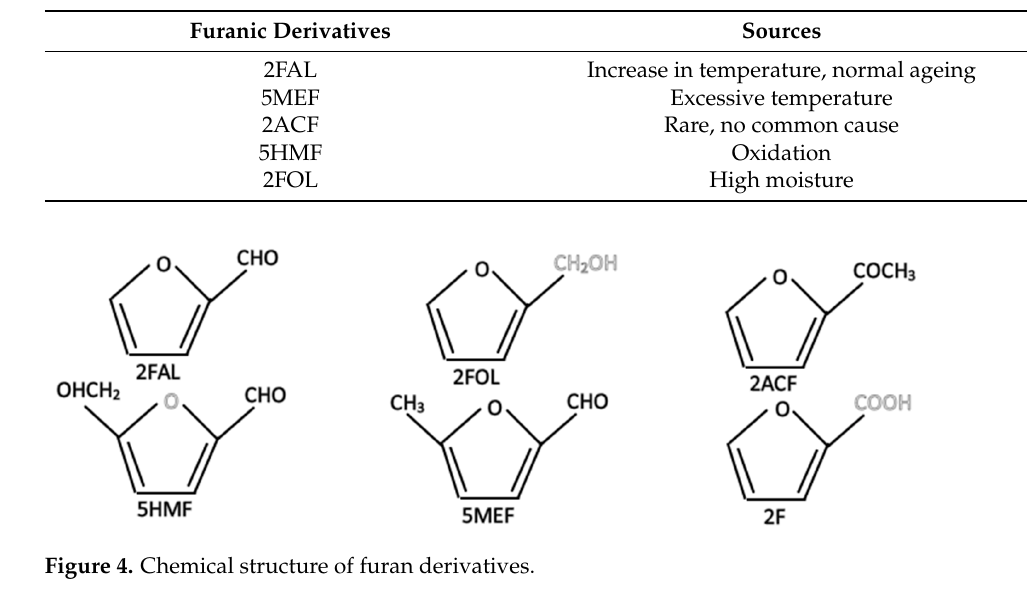
Table 2. Sources of furanic derivatives formation.